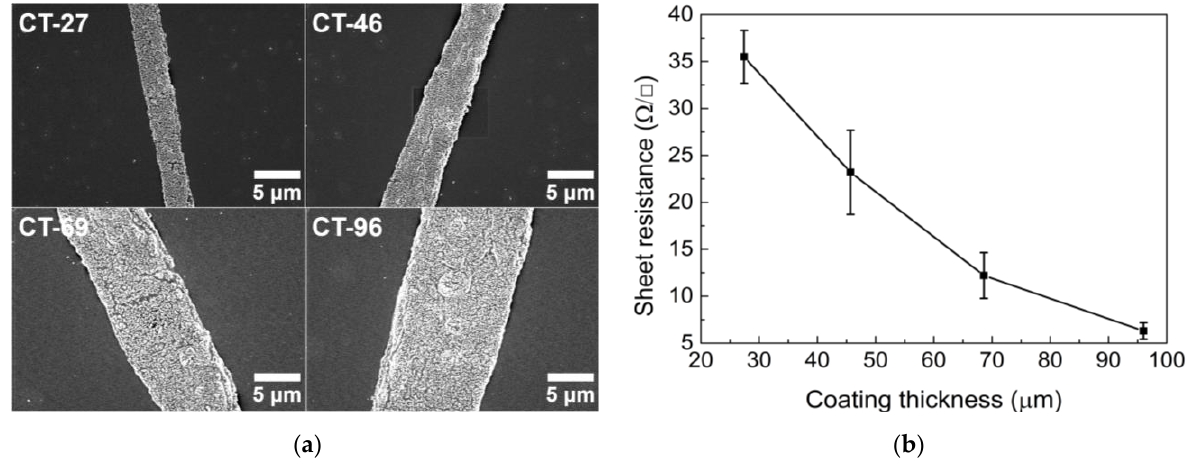
Figure 7. ( a ) SEM images of conductive lines in TCFs and ( b ) sheet resistance under different coating thickness